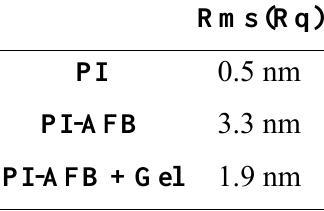
Table 1. Surface roughness values (Rms) of PI, PI-AFB and gelatin-coated PI obtained using AFM analysis.